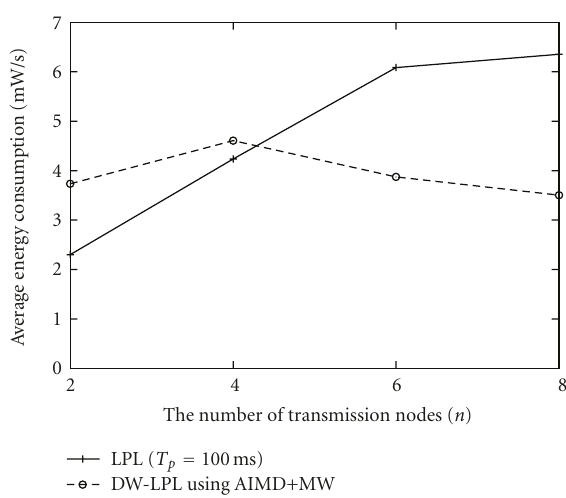
Figure 9: The experiment result of LPL and DW-LPL for varying the number of